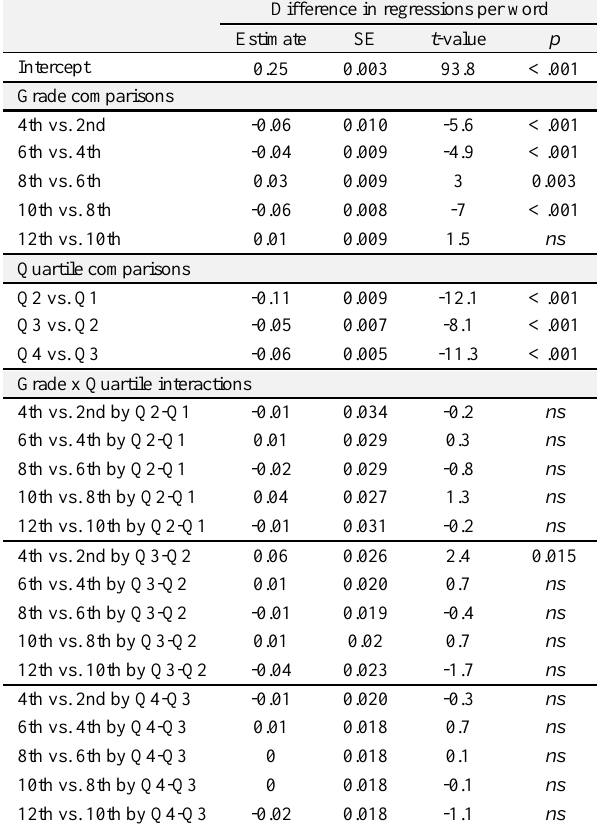
Table 5. Differences in Number of Regressions Per Word Be- tween Grades and Reading Rate Quartiles Difference in regressions per word Estimate SE t -value Intercept